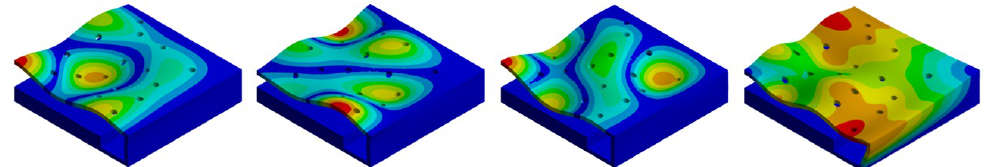
Figure 22. Four package modes for case (e): 6th mode shape at 80.13 kHz ( left ), 7th mode shape at 102.43 kHz ( center-left ), 8th mode shape at 102.81 kHz ( center-right ), 16th mode shape at 154.38 kHz ( right ).